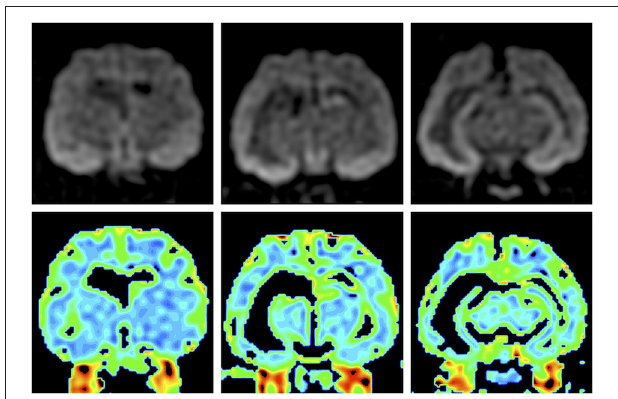
FIGURE 4 | Preoperative isotropic diffusion-weighted imaging (upper row) and colored apparent diffusion coefficient maps (lower row). Bilateral hippocampi and the right amygdala and temporo-occipital cortex showed hyperintensity, but there were no significant changes on the apparent diffusion coefficient